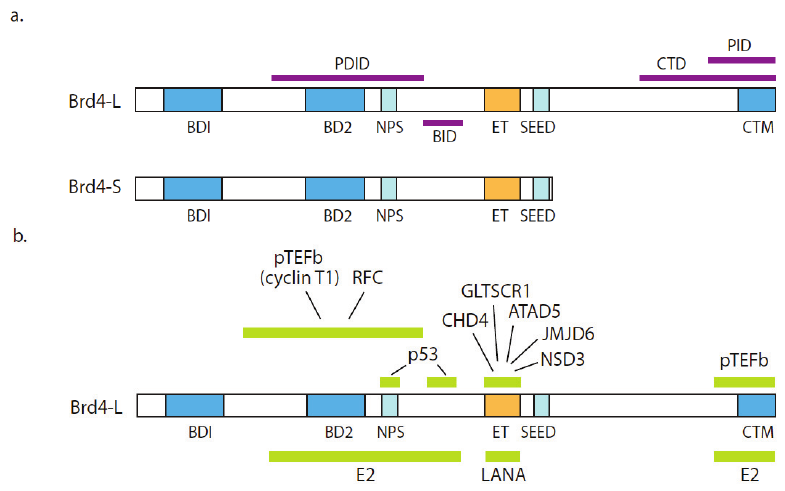
Figure 3. Structure and function of the Brd4 protein. ( a ) Domains of the Brd4 protein.